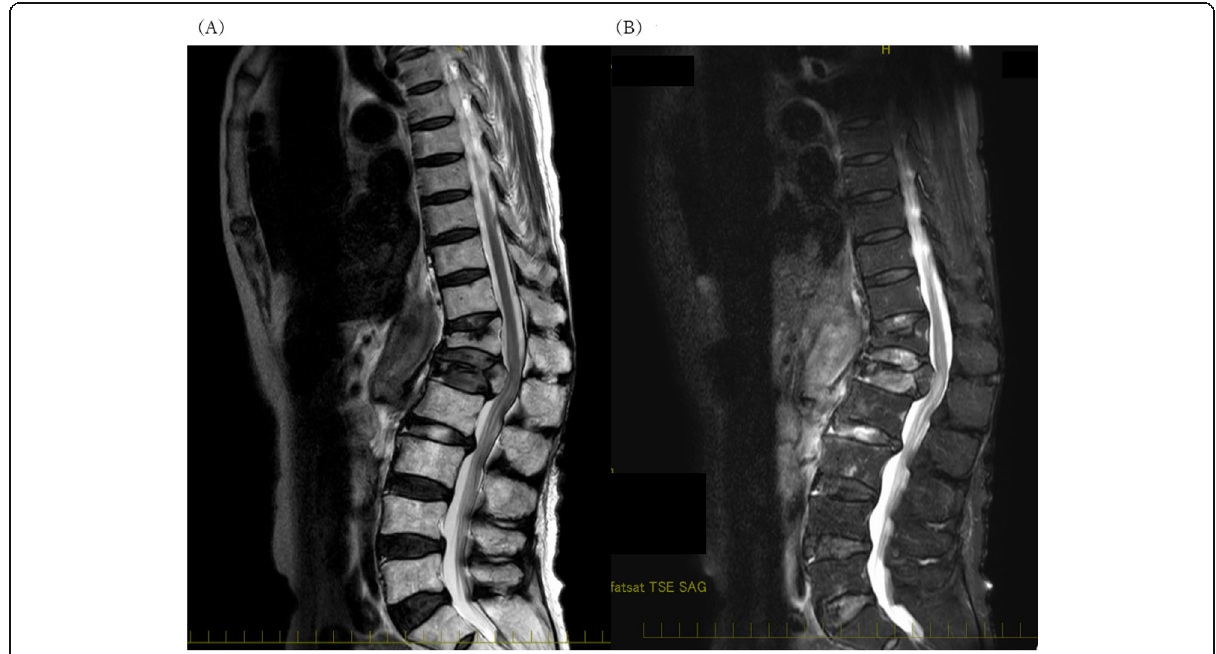
Fig. 2 Magnetic resonance imaging on postoperative day 1. A A sagittal, T2-weighted image revealed the compressed spinal cord at the L1 level. B A sagittal, fat-suppression, T2-weighted image revealed a low intensity of the T12 vertebra and a high intensity of a portion of the L1